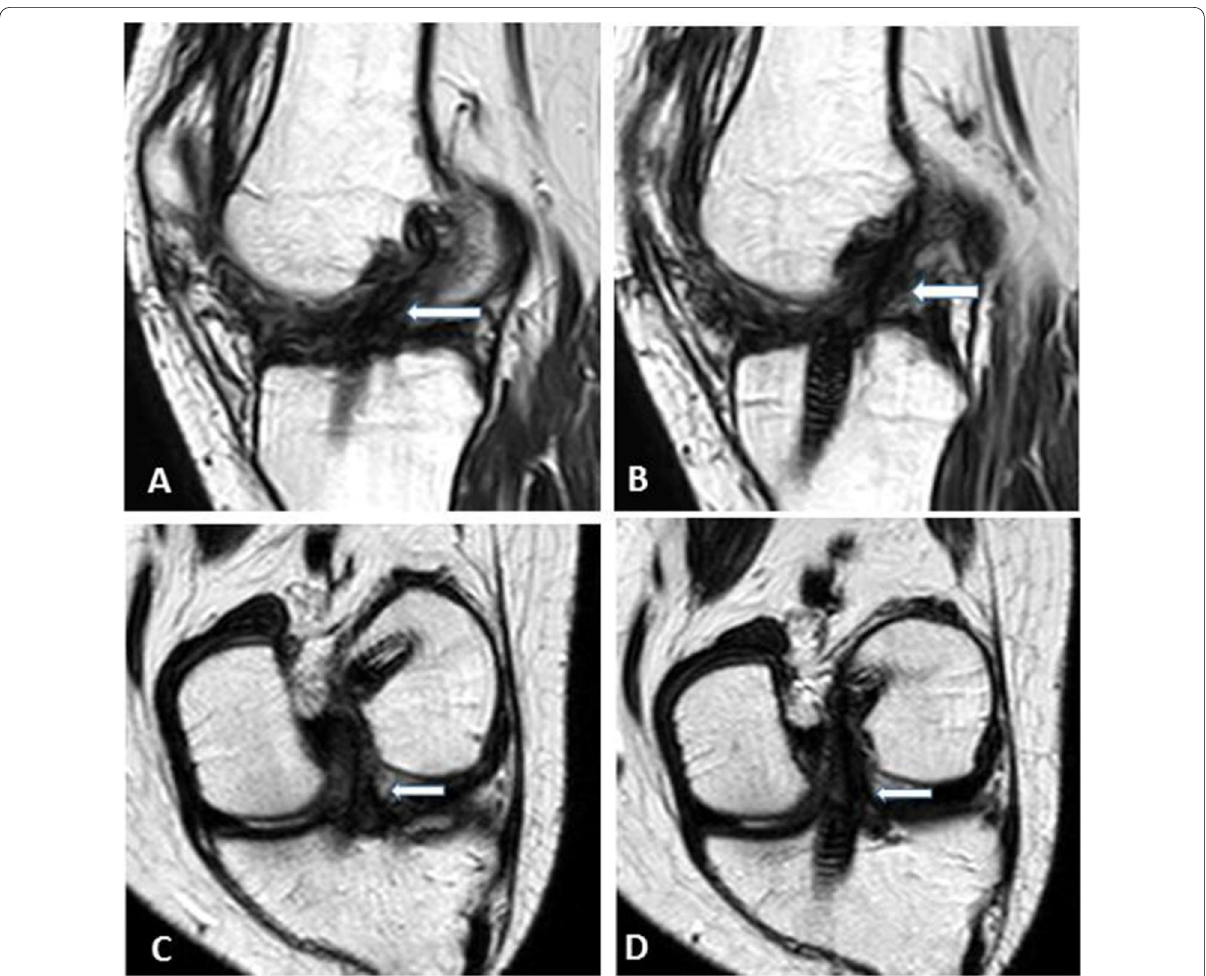
Fig. 6 a , b sagittal oblique T2 WIs; c and d coronal oblique T2 WIs (protocol B) of the same patient mentioned in Fig. 5, showing interstitial high signal elevation and thinning at the middle and tibial portion of the graft suggesting a grade 1 injury rather than grade 0 (thick white arrows). Arthroscopic examination 8 months later confirmed grade 1